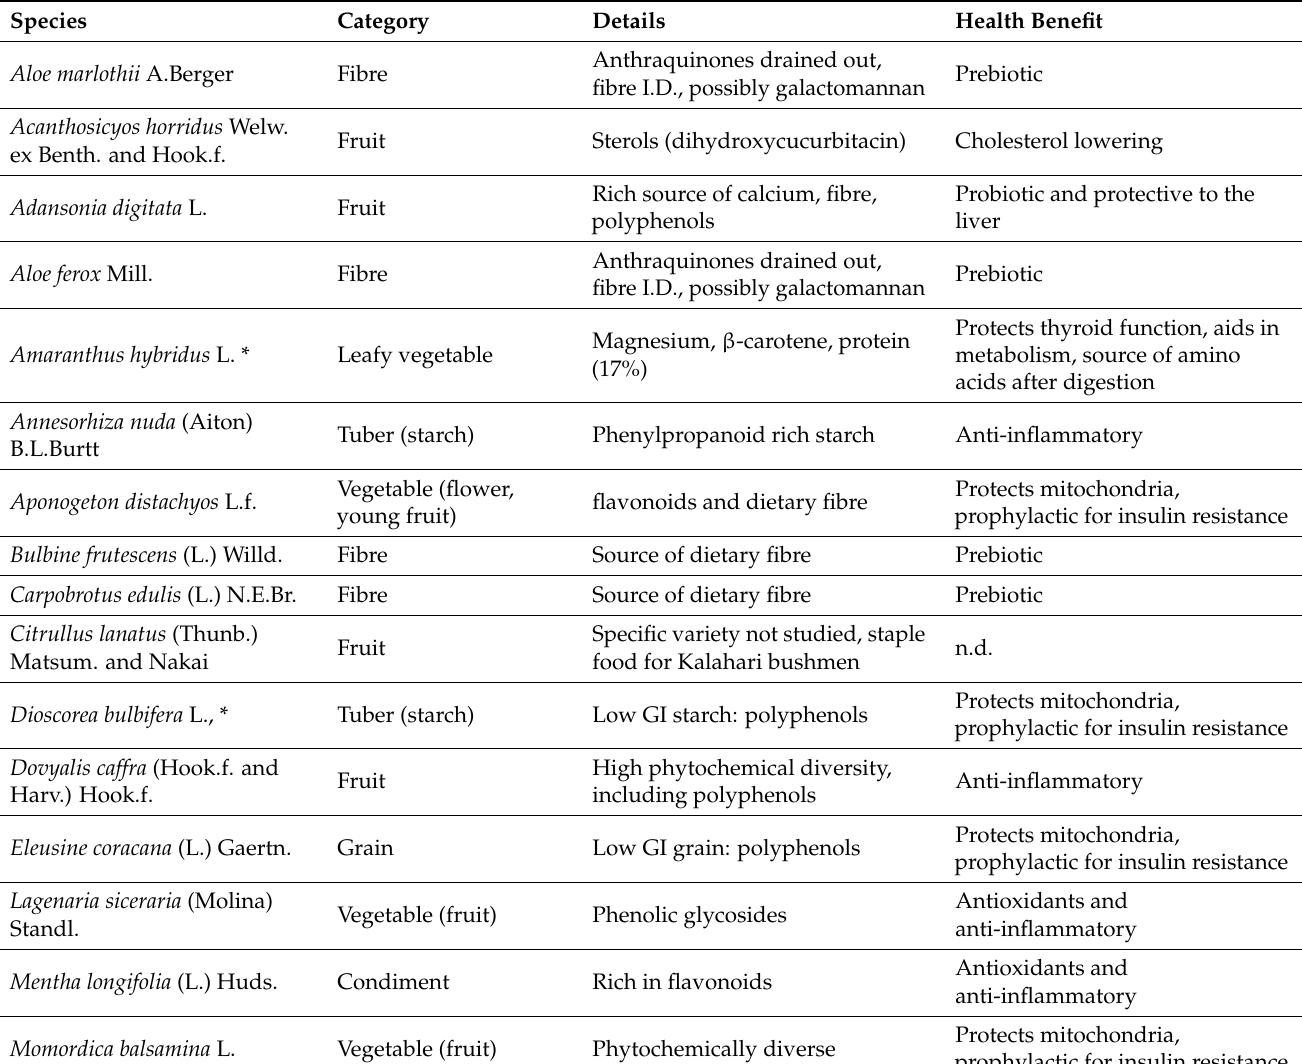
Table 1. A summary of the wild foods that are reviewed, and the mechanism of health benefit interpreted from the groups of phytochemicals present in the food